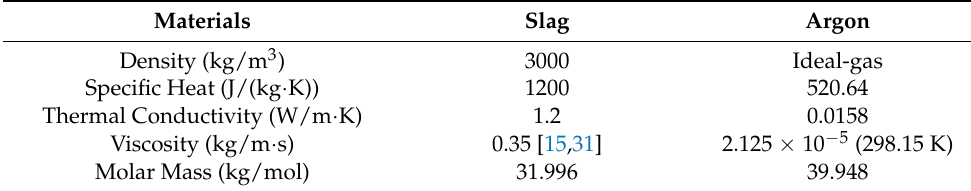
Table 2. Parameter settings of materials in the fluid domain. Materials Slag Argon Density (kg/m 3 ) 3000 Ideal-gas Specific Heat (J/(kg · K))